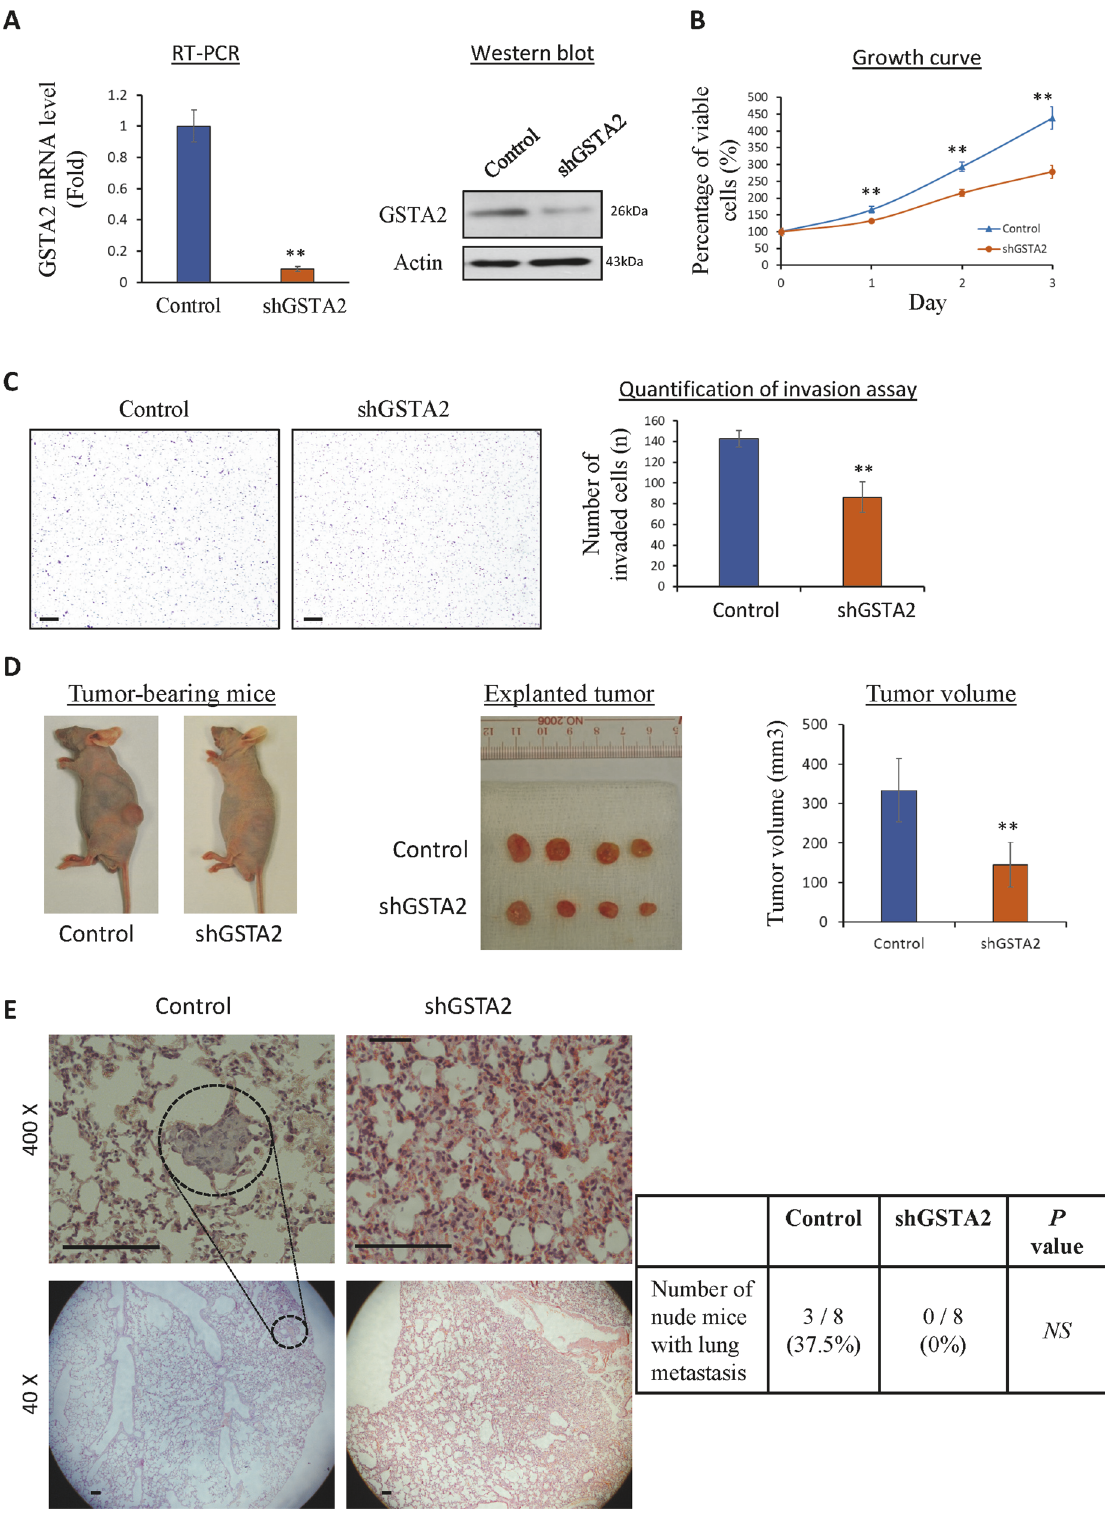
Fig. 6 Suppression of GSTA2 expression inhibited the growth and metastasis of HCC. A Stable GSTA2-suppressing MHCC97L HCC cell (97L in short) exhibited signi fi cant down-regulation of GSTA2 mRNA and protein. B MTT proliferation assay for control and GSTA2-suppressing HCC cells. C Matrigel invasion assay for control and GSTA2-suppressing HCC cells. Scale bar: 200 μ M. D Xenograft subcutaneous tumor model in nude mice. E H&E staining of lung tissues in metastatic tumor. The dashed circle indicates the presence of an HCC tumor in the lung. Scale bar: 100 μ M. Control, MHCC97L-shControl stable cells; shGSTA2, MHCC97L-shGSTA2 stable cells; NS, no signi fi cance; * P < 0.05; ** P <